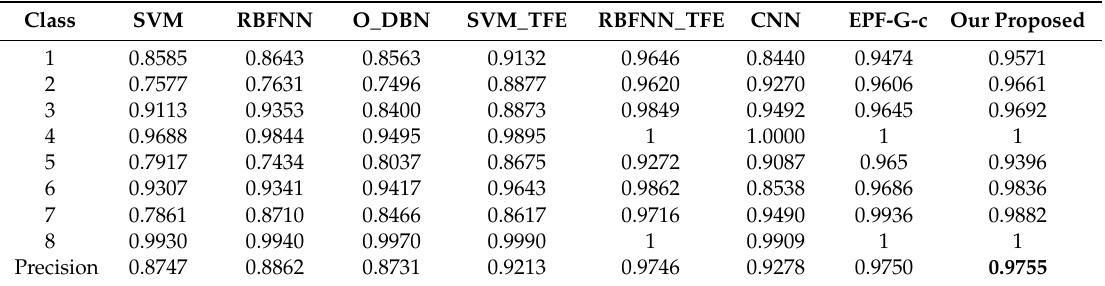
Table 7. Classification precision of different algorithms on Indian